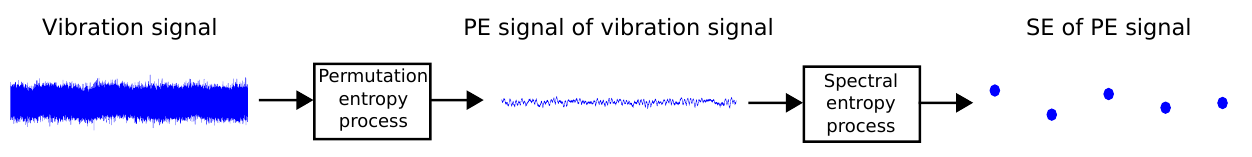
Figure 6. Diagram of the signal analysis procedure for spectral entropy of the permutation entropy signal SepEn